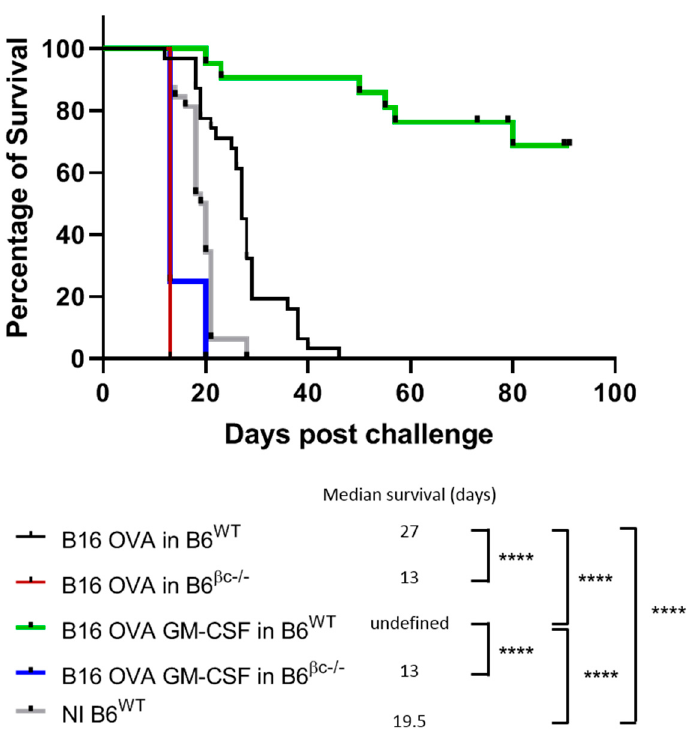
Figure 1. Mice without a functional GM-CSF receptor do not mount anti-tumor immunity. C57BL/6 wild type (B6 WT ) and C57BL/6 β c-/- (B6 β c-/- ) mice were immunized with irradiated B16-OVA ( n = 31 for B6 WT and n = 4 for B6 β c-/- ) or B16-OVA GM-CSF secreting cells ( n = 21 for B6 WT and n = 4 for B6 β c-/- ). Non-immunized (NI) B6 WT ( n = 32) mice were used as a negative control. Seven days later, the mice were then challenged with a contro-lateral s.c. injection of live B16-OVA tumor cells. Following the injection, the mice were monitored for survival and were sacrificed when tumors ulcerated or reached 10 mm in diameter. The survival of the animals was plotted as a Kaplan–Meier curve for each group and was analyzed by the log rank-survival test. Differences regarded as statistically significant between the groups are presented as follows: * p < 0.05, ** p < 0.01, *** p < 0.001 and **** p < 0.0001.